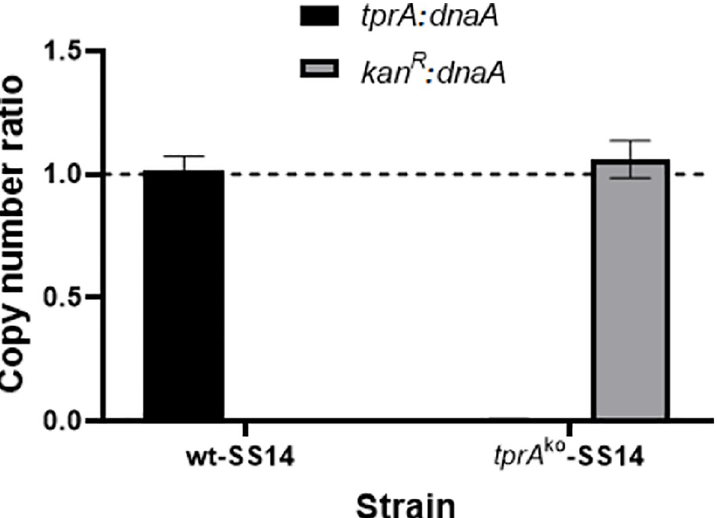
Fig 3. Droplet digital PCR (ddPCR) on DNA template from the tprA ko - and wt- SS14 strain harvested at Passage #8 post-transformation showing rations between the kan R , dnaA , and tprA targets. tprA : dnaA ratio for the tprA ko - SS14 strain was 0.006. The kan R : dnaA ratio for the wt-SS14 was zero.